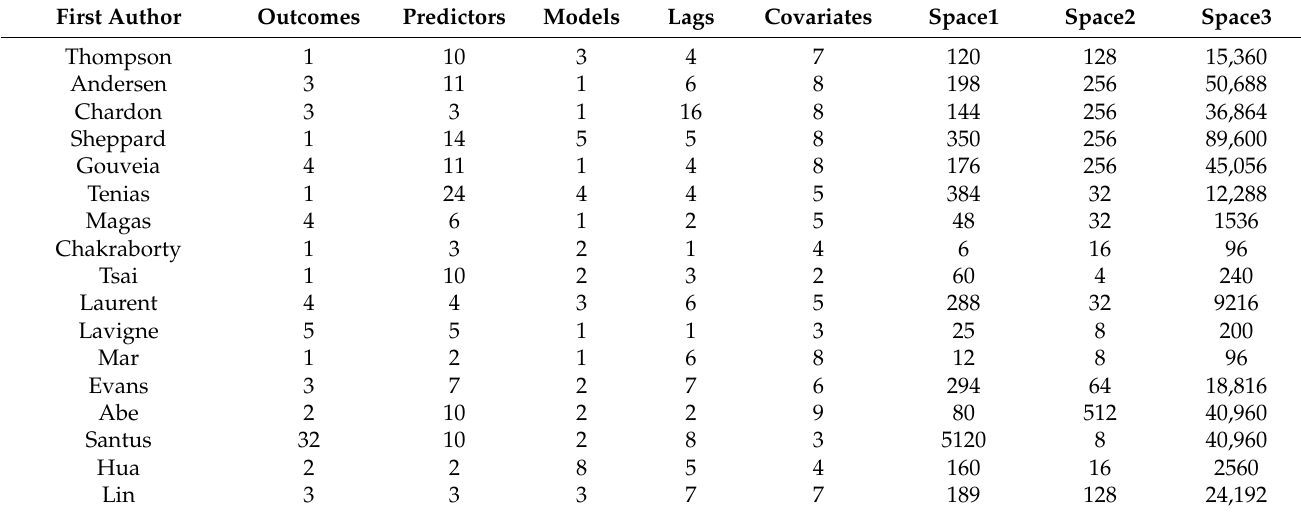
Table 3. Authors, variable counts, and analysis search spaces for the 17 randomly selected base papers from Zheng et al. [48]. First